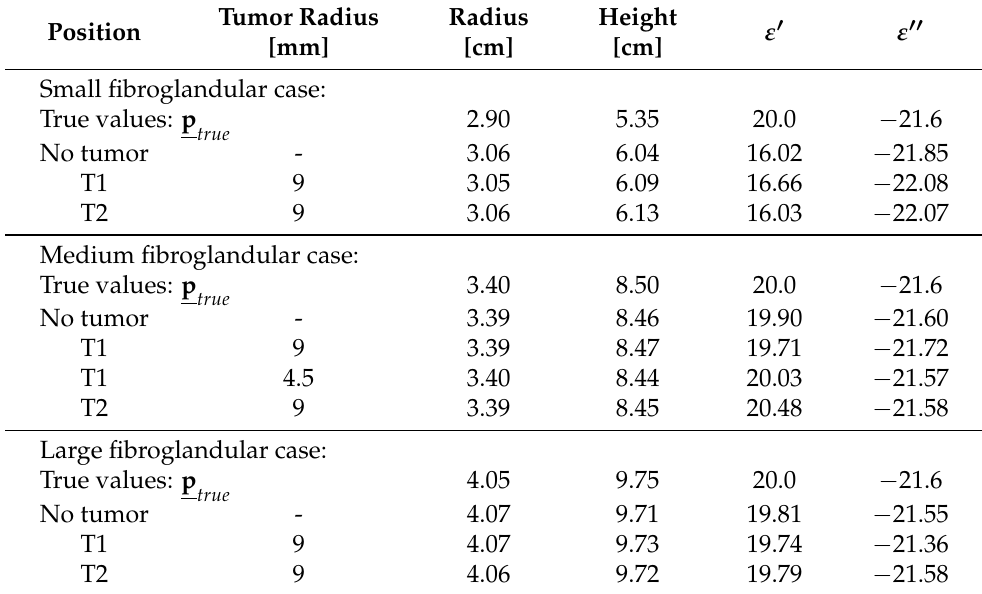
Table 3. Summary of fibroglandular parameter predictions for synthetic examples with − 80 dB